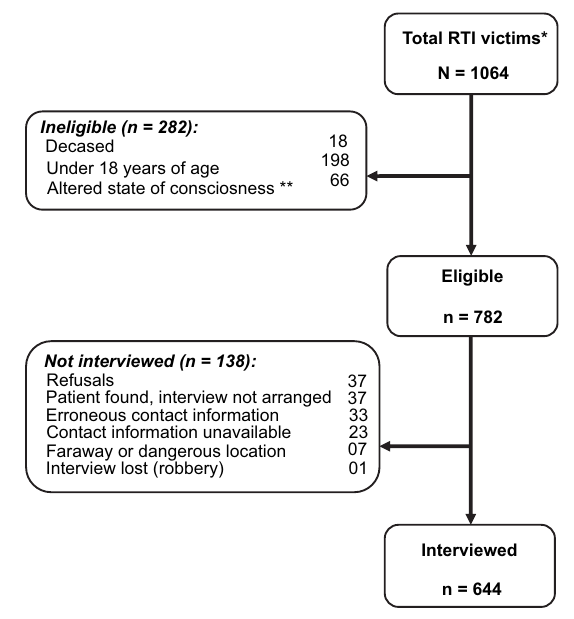
Figure 1. Flowchart of study participation. * Victims admitted to emergency services of health care facilities (HCFs) included in the study. This includes all patients cared for in the emergency department and discharged with or without previous hospitalization. ** Altered states of consciousness and speech directly attributable to the road traffic incident (RTI; for example, encephalocranial traumas) or not (for example, alcohol intoxication, Alzheimer’s, dementia, senility, etc.) that affected the perception of the event and did not allow the respondent to answer the